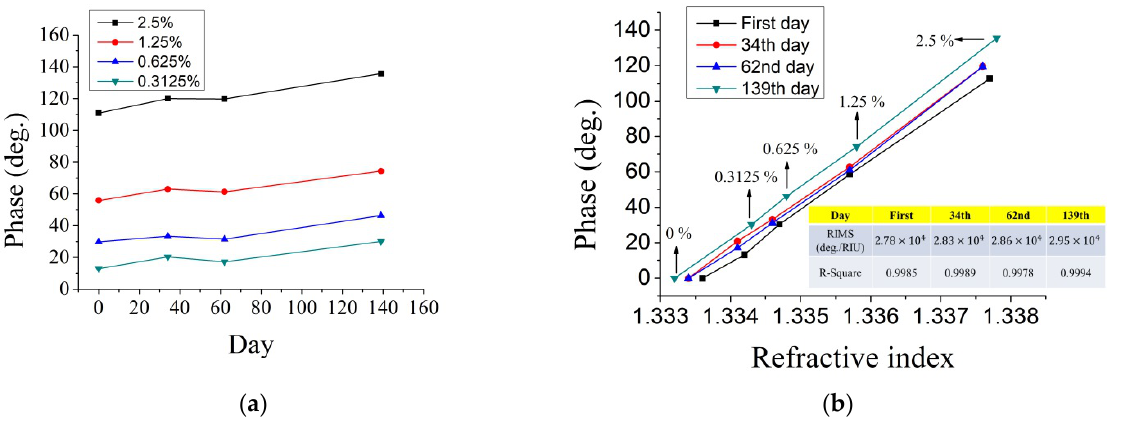
Figure 6. Long-term stability measurement: ( a ) phase versus the measured day for different concentrations; ( b ) phase versus the RI for different measurement days.